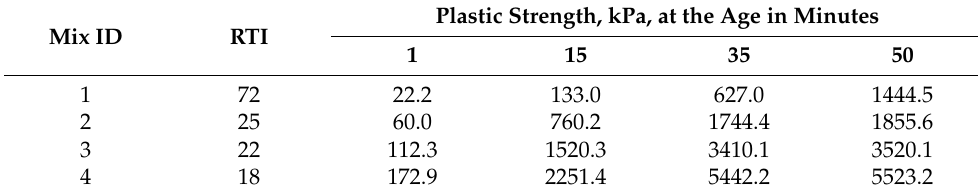
Table 3. Rheological characteristics of mortars.